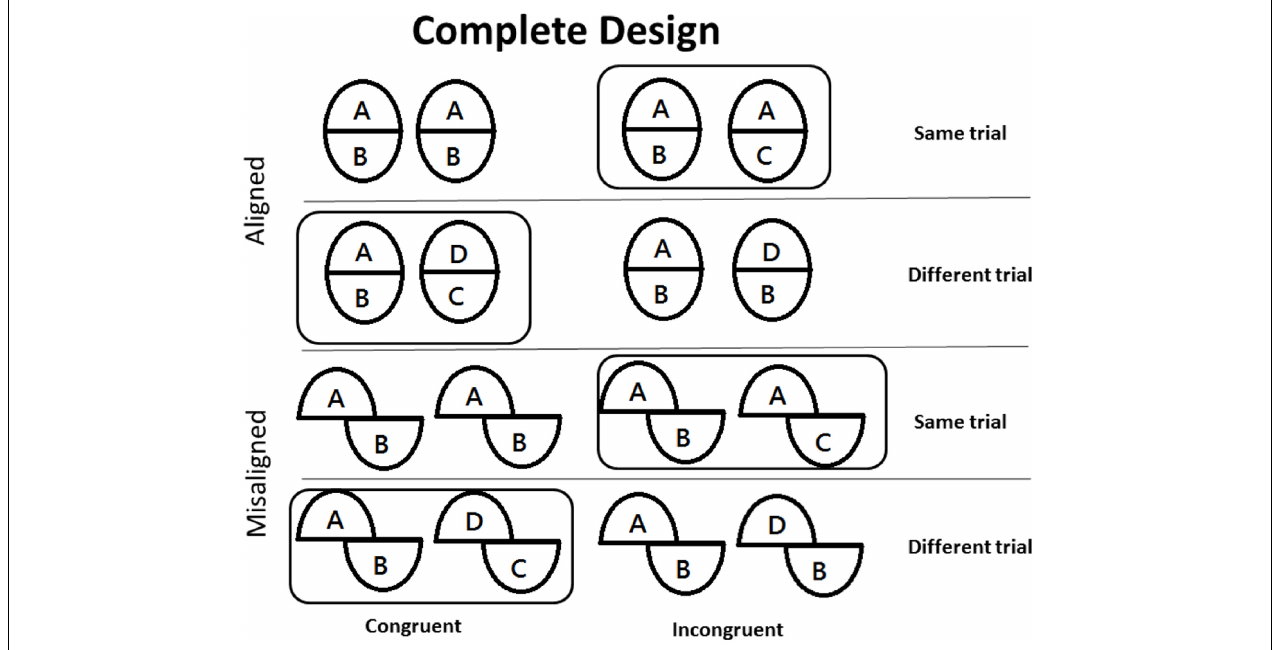
FIGURE 2 | Illustration of the complete design that includes partial design trials. Capital letters denote face part identity, where the same letters indicate identical face halves, and different letters indicate different face halves. Many researchers have used the partial design, denoted by black surrounding frames, to demonstrate holistic processing, but in the partial design the irrelevant (bottom) parts were always different. Moreover, only performance on “same” trials were analyzed. In contrast, in the complete design, congruency effects, which include both “same” and “different trials,” are computed as a measure for holistic